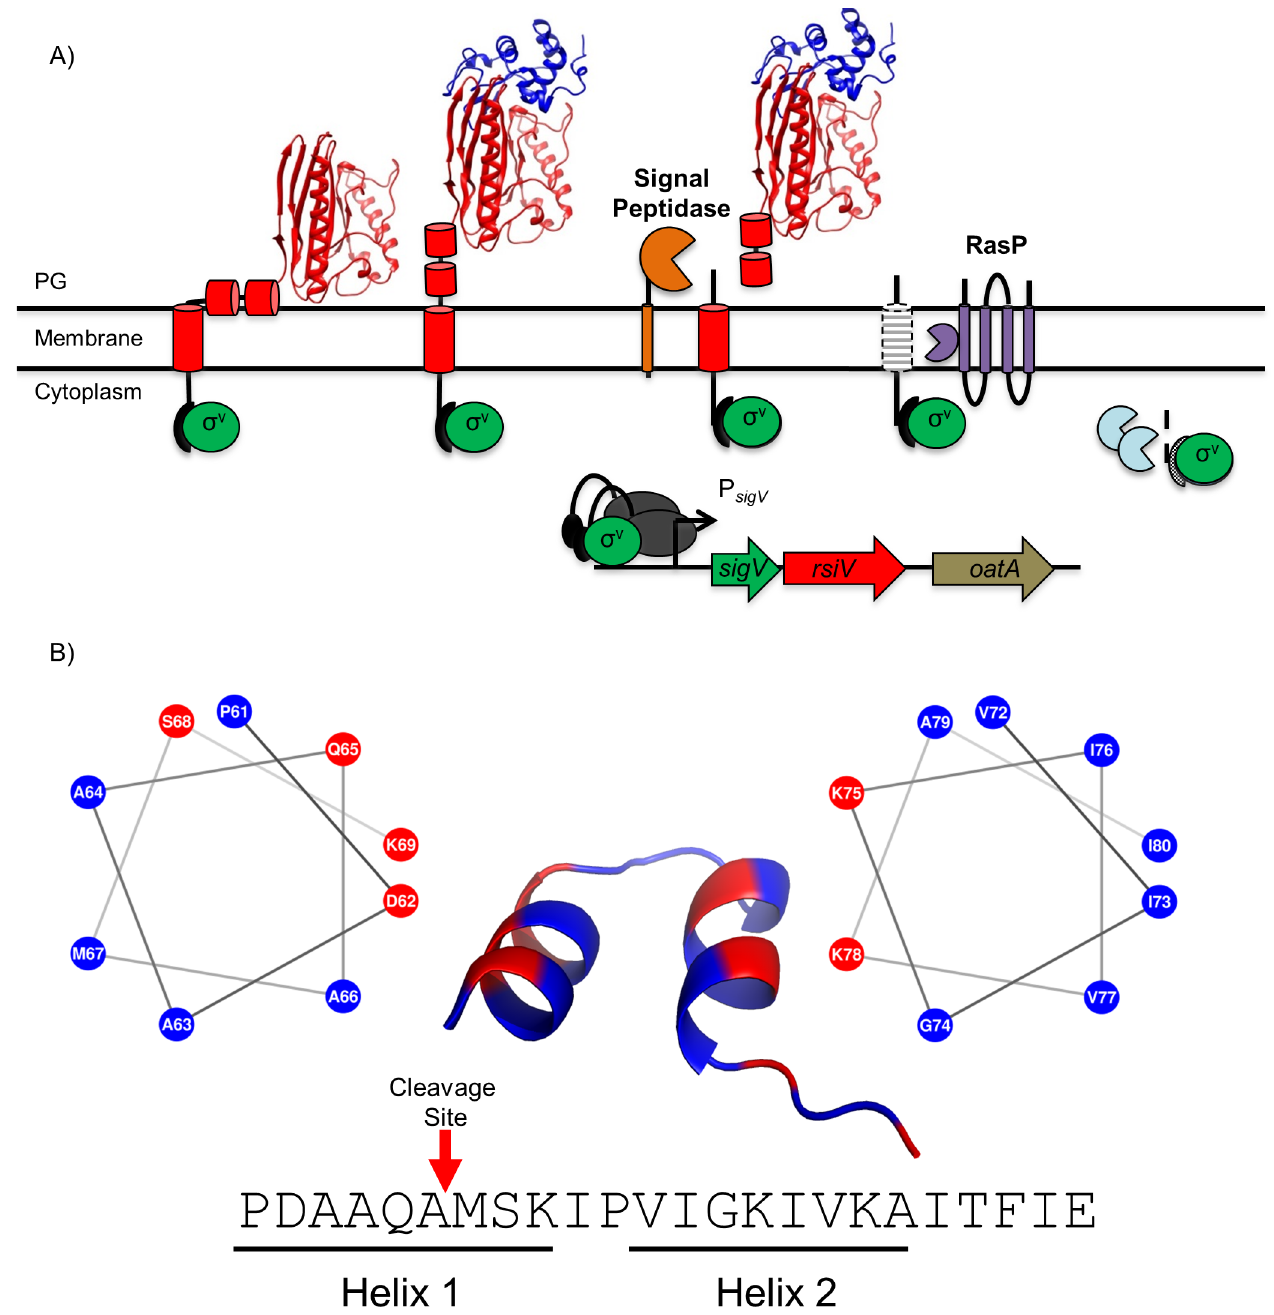
Fig 1. Model of σ V activation. A. The σ factor σ V is shown in green, the anti-σ factor RsiV is shown in red with cartoon cylinders representing the unsolved residues 1–75. Signal peptidase (Sip) is shown in yellow, the site two protease RasP is shown in purple and lysozyme is shown in blue. In the absence of lysozyme, RsiV is resistant to signal peptidase cleavage via the interaction of two amphipathic helices with the membrane that restrict access to the cleavage site. In this state RsiV sequesters σ V activity and prevents transcription of σ V -dependent genes. Once RsiV binds lysozyme, the amphipathic helices are forced out of the membrane and signal peptidase is allowed access to the cleavage site leading to site-1 degradation of RsiV. The remaining transmembrane portion of RsiV is further degraded by the site-2 protease RasP, after which RsiV is further degraded by cytosolic proteases. This allows σ V to interact with RNA polymerase (Grey) and promote transcription of σ V -dependent genes. B. An set of 203 RsiV homologs were aligned using Clustal Omega [70] and the alignment was used with weblogo [44] to generate a sequence logo (S1 Fig). The corresponding sequence in B . subtilis was run through the secondary structure prediction software PEP-FOLD-3 [45] and the results are shown by the cartoon structure with two α -helices. Each helix was modeled with a helical wheel generator [47] and labeled below the sequence designated as Helix 1 (Left) and Helix 2 (Right). Hydrophobic amino acids are represented in blue and hydrophilic residues are represented in red. The cleavage site of RsiV is represented with a red arrow. This bioinformatic analysis suggests the presence of two conserved amphipathic helices directly after the transmembrane domain of RsiV that function to protect RsiV from site-1 cleavage by signal peptidase. https://doi.org/10.1371/journal.pgen.1007527.g001 PLOS Genetics | https://doi.org/10.1371/journal.pgen.1007527 July 18,